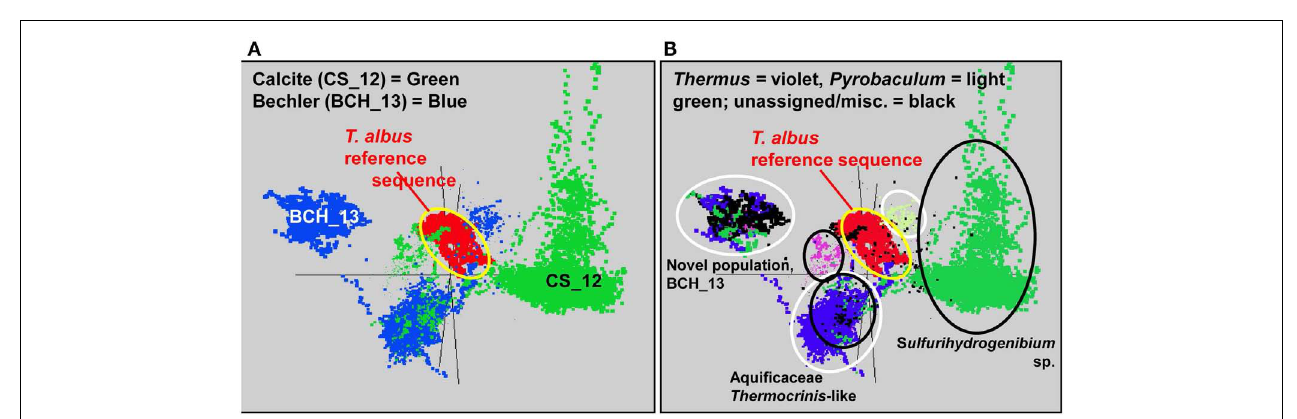
FIGUREA1 | Recruitment of metagenome sequence reads ( ∼ 800bp per read) from sixAquificales streamer samples to the most relevant reference genomes currently available in reference databases . Recruitment of metagenome sequence fragments across the complete genomes ( x -axis) are shown from 50 to 100% nucleotide identity ( y -axis). Site Colors:Yellow = Dragon Spring (DS_9), Red = One Hundred Spring Plain (OSP_14); Green = Mammoth Hot Springs